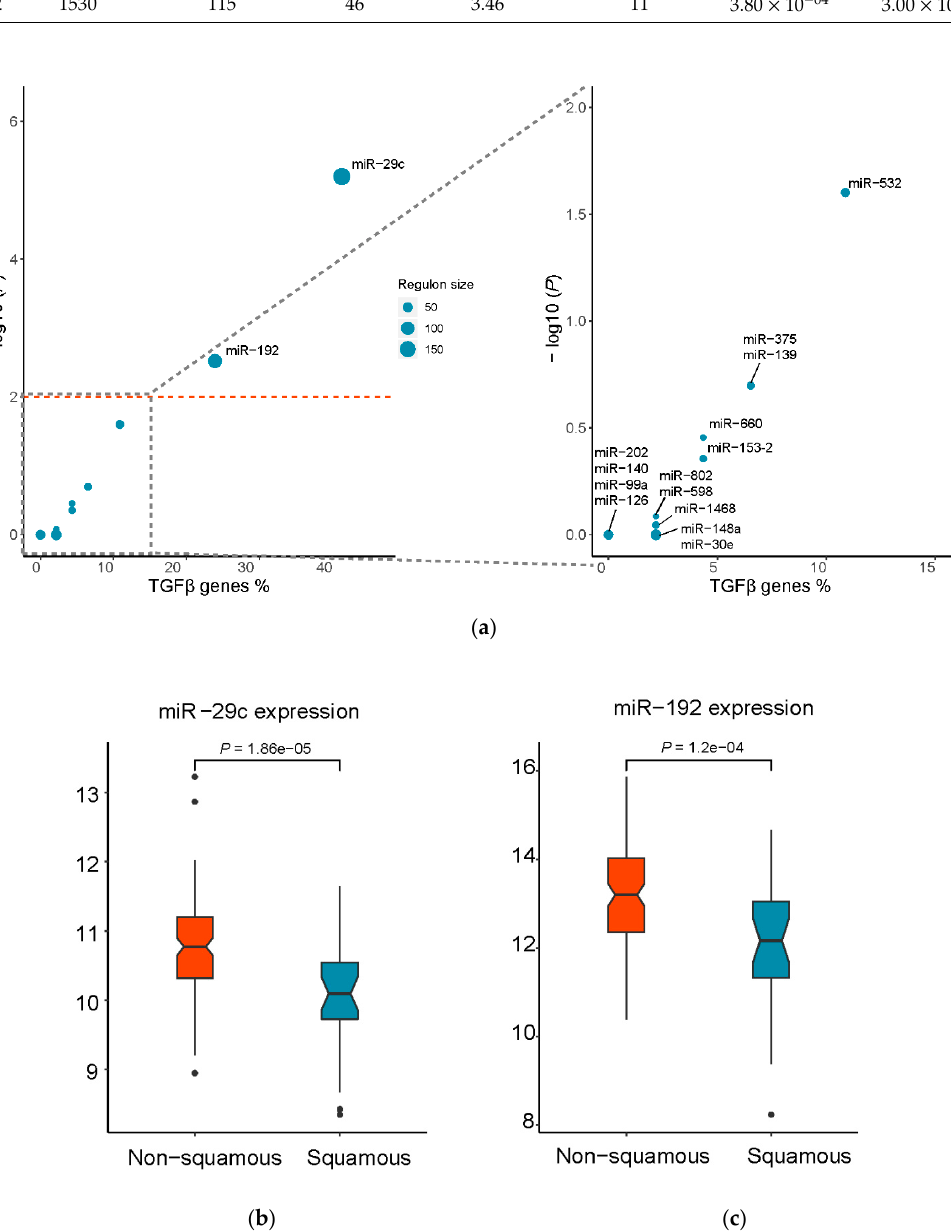
Figure 4. Master regulator analysis identified miRNAs key to the regulation of the TGF β signaling pathway. ( a ) Prioritization of putative master regulators based on the statistical significance of overrepresentation of the regulon of each miRNA for TGF β signature genes ( − log 10 transformed BH-adjusted p -value, hypergeometric tests) and the proportion of TGF β genes regulated by a miRNA; (b,c ) Compared to non-squamous subtypes, miR-29c and miR-192 are significantly downregulated in the squamous subtype in TCGA dataset ( n = 31 for squamous, n = 118 for non-squamous, the p -values were corrected using the Benjamini-Hochberg